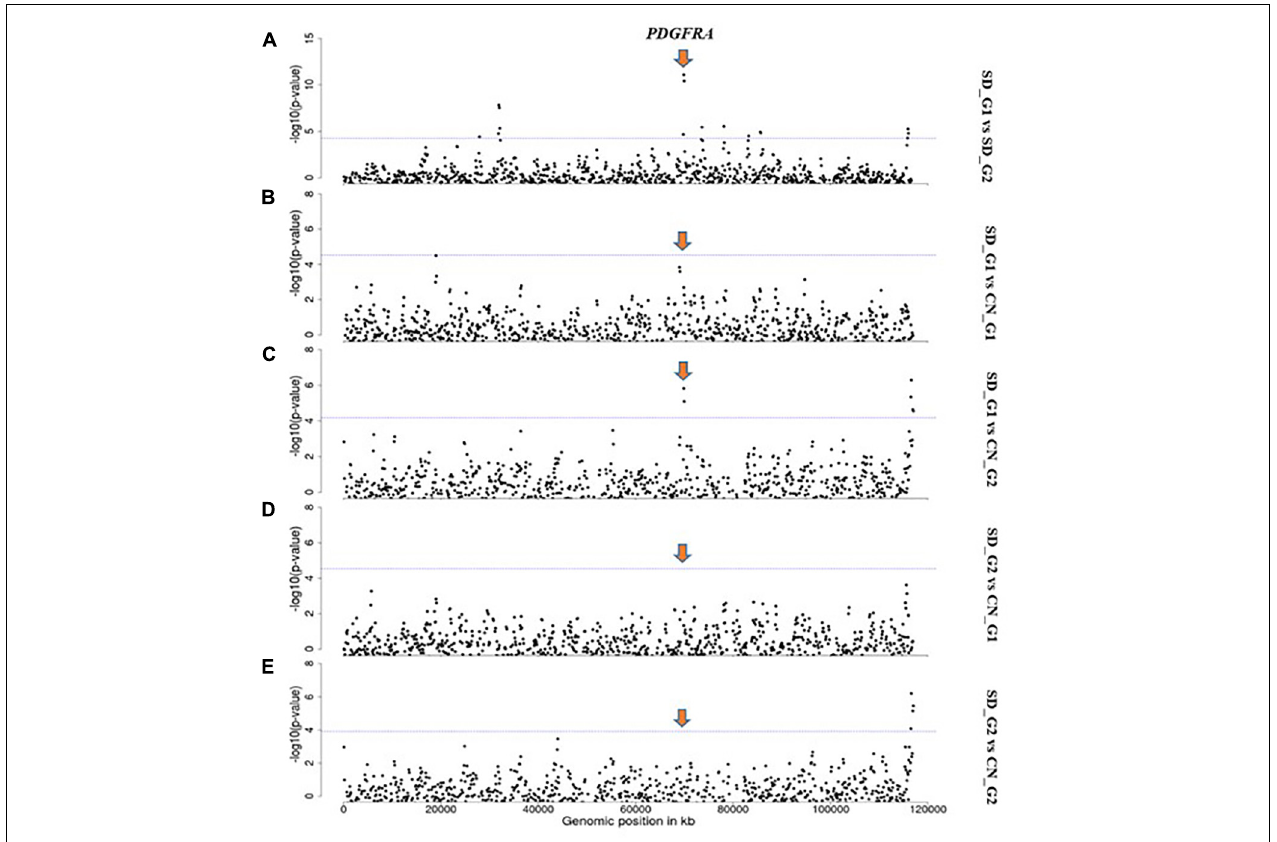
FIGURE 8 | Manhattan plots showing the strongest candidate signatures of selection as determined with F ST on OAR6. (A) SD_G1 vs. SD_G2; (B) SD_G1 vs. CN_G1; (C) SD_G1 vs. CN_G2; (D) SD_G2 vs. CN_G1; (E) SD_G2 vs.